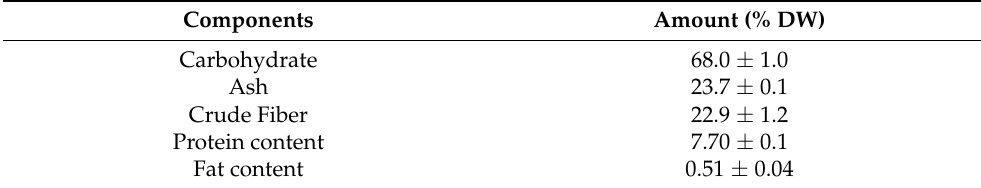
Table 1. Chemical composition of the freeze-dried S. vulgare .